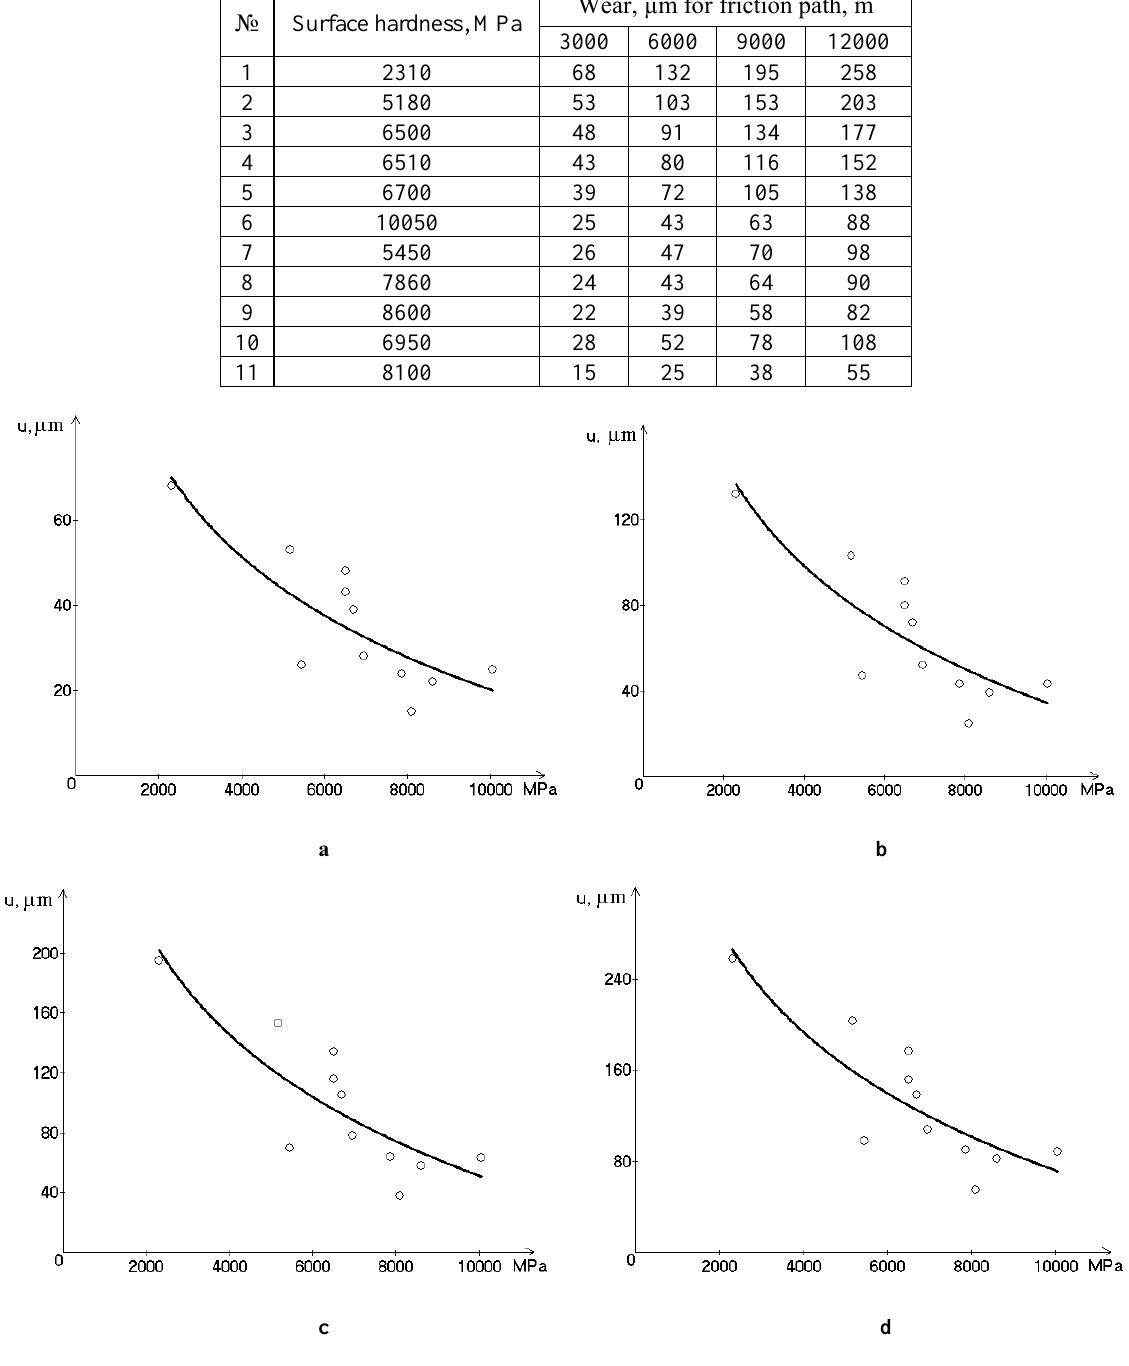
Screw wear values for different values of surface hardness and friction path [3] Wear, µm for friction path, m № Surface hardness, MPa